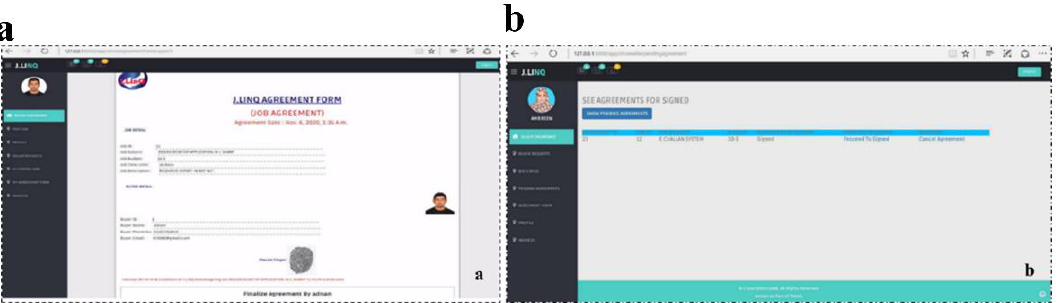
Figure 17. ( a ) Finalize agreement with a biometric signature from the buyer side. ( b ) Options for the seller to sign the contract of canceling the